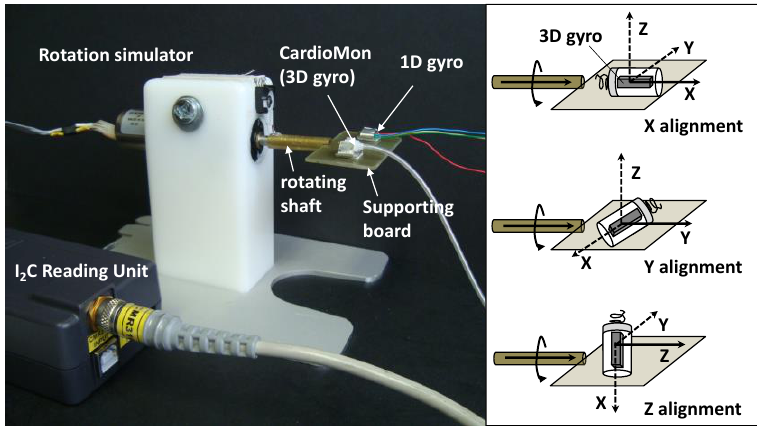
Figure 4. The mechanical simulator with the two mounted gyro sensors.